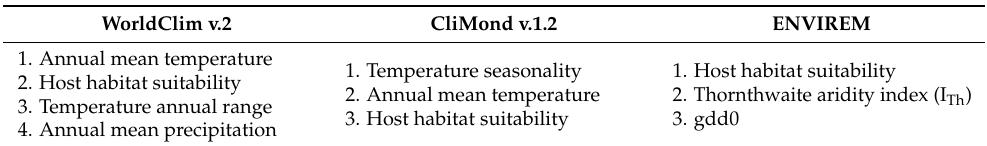
Table 2. Variables explaining in sum > 60% of variance in the SDM (ranked in order of varia- ble importance).